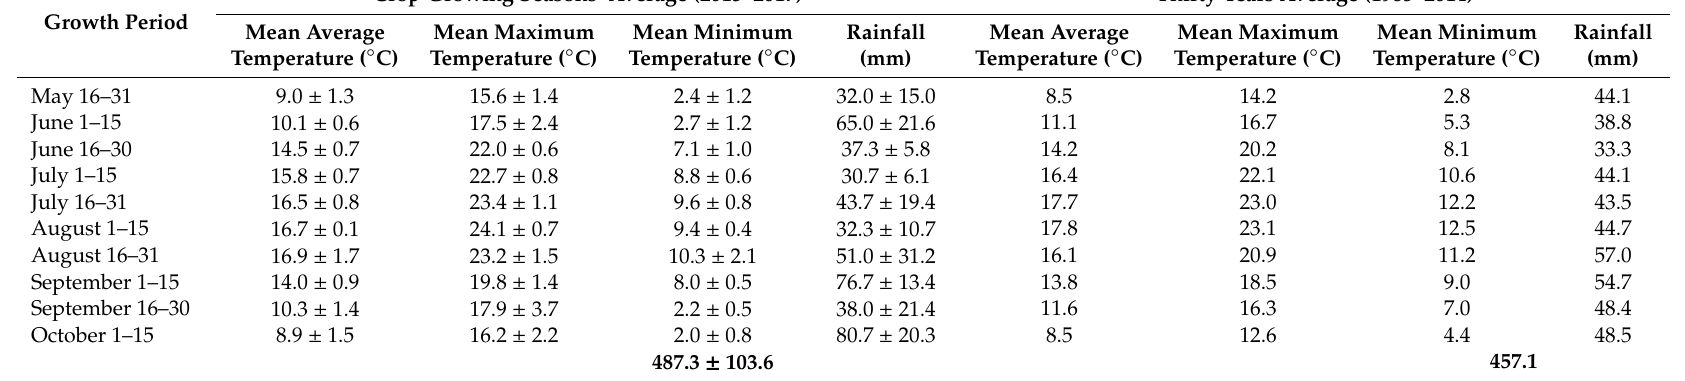
Table 2. Mean average air temperature, mean maximum and minimum temperature and rainfall at experimental site during three growing seasons. Crop growing season average represents means of three growing seasons ± standard error ( n = 3 ), whereas the last thirty years data represent means from 1985–2014 for crop growth period.